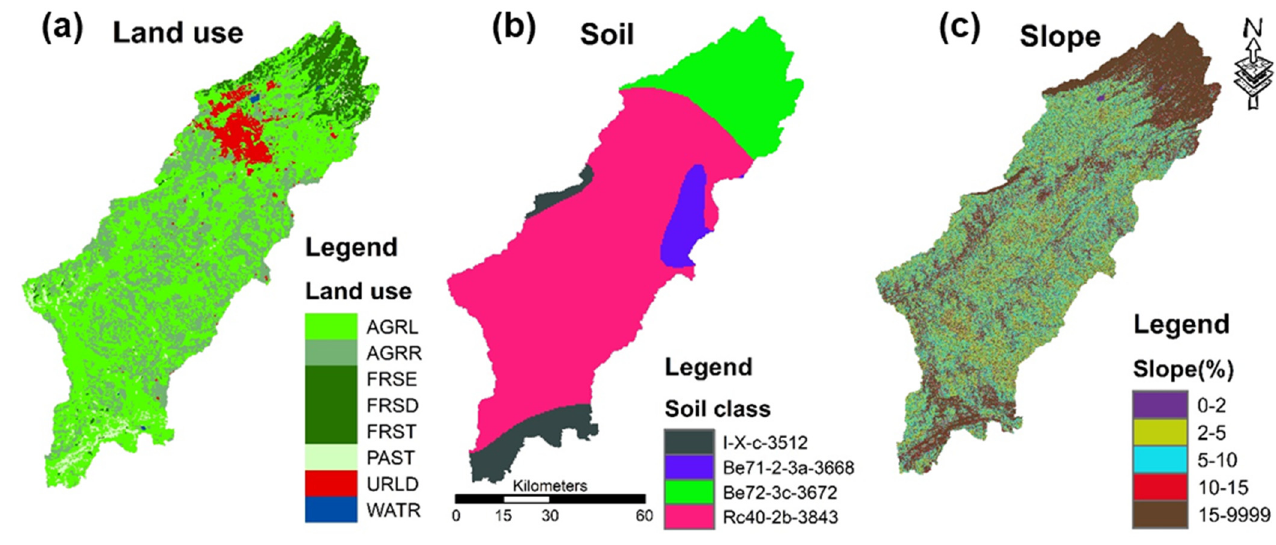
Figure 3. ( a ) map of land use, ( b ) map of soil, and ( c ) slop map of the SRB.